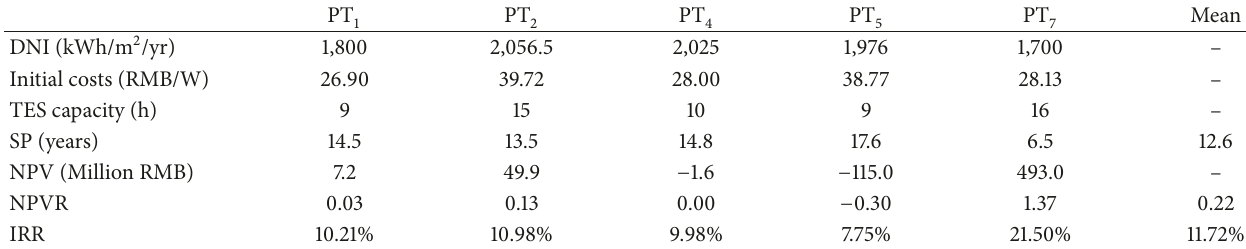
Table 4: Cost-benefit for the PT-CSP technology of